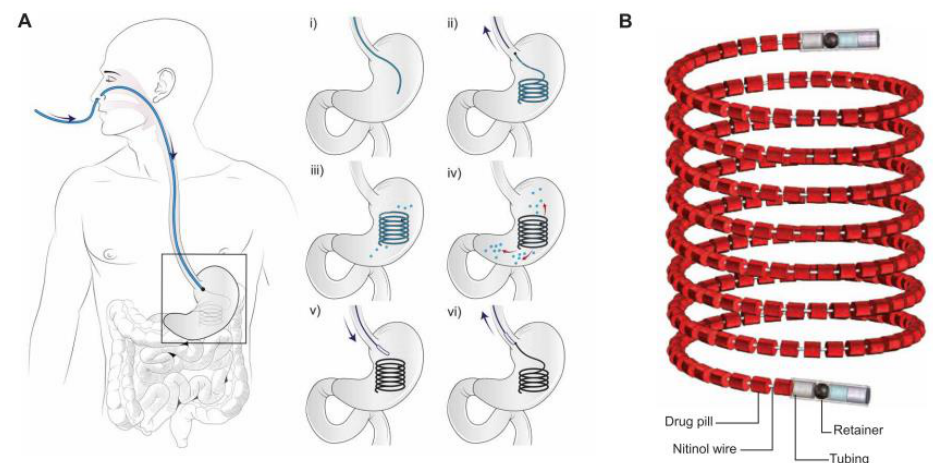
Figure 5. Schematic of the intragastric placement (A) and detailed view (B) of the tubular gastroretentive device proposed by Verma et al. and reprinted from Reference [52].